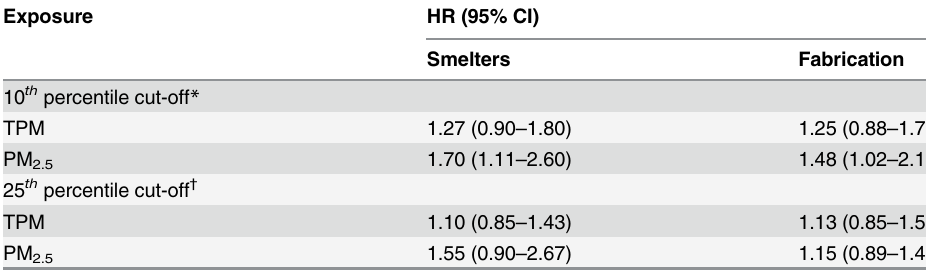
Table 2. Hazard Ratios (95% CI) for the risk of IHD comparing exposure above and below the 10 th and 25 th percentile of exposure distributions for TPM and PM 2.5 stratified by work process type. Exposure HR (95% CI) Smelters Fabrication